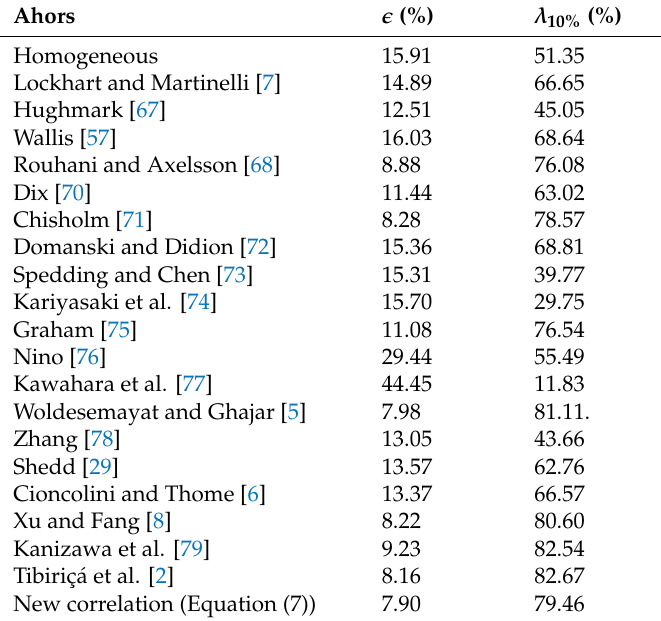
Table 7. Mean absolute error and the percentage of the whole database with error up to 10% for the correlation